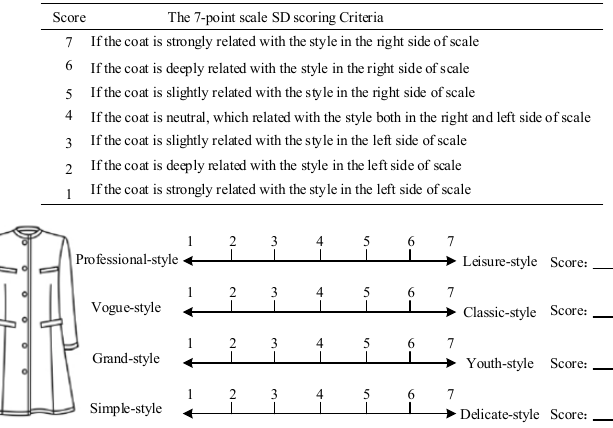
Figure 5. One of the questionnaires.